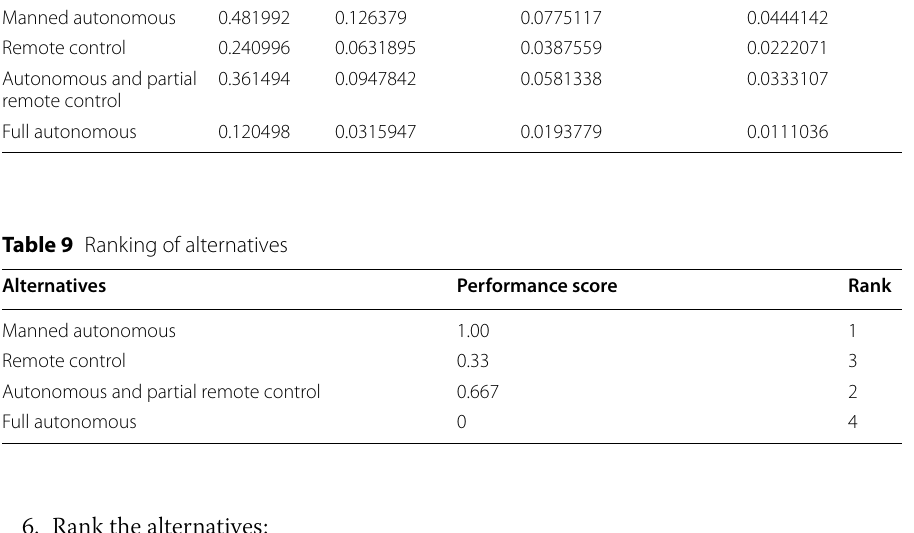
Table 8 Weighted matrix of alternatives Alternatives